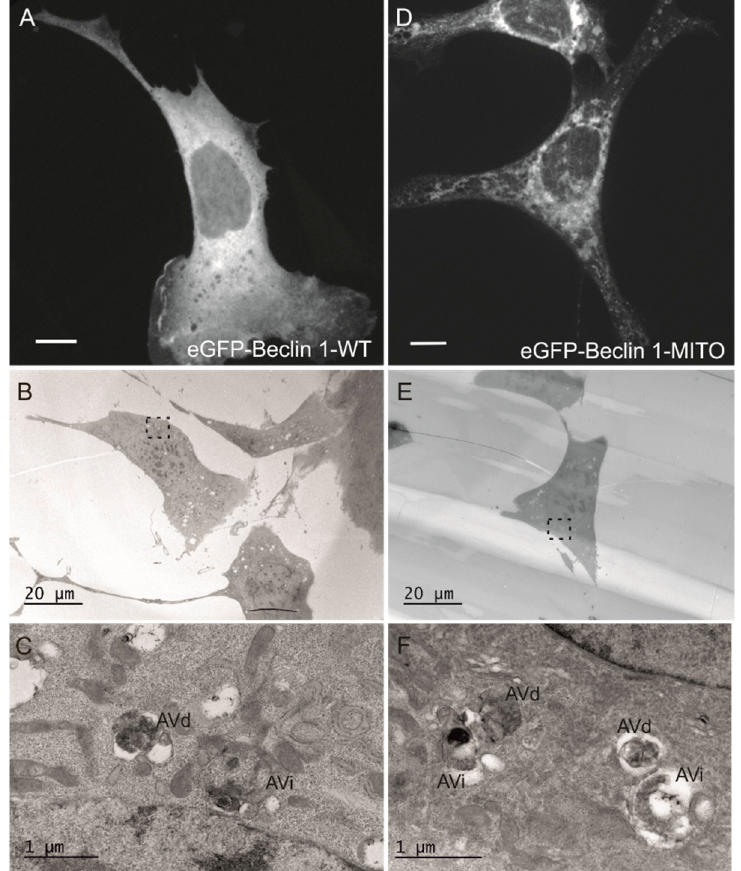
Figure 7. Electron microscopy analysis of autophagosomes in MEF-ULK1/2-KO cells expressing eGFP-Beclin 1-WT or eGFP-Beclin 1-MITO. The cells were transfected with eGFP-Beclin 1 constructs and starved in amino-acid free medium for 1 h before fixation. ( A – C ) eGFP-Beclin 1-WT. ( A ) Confocal image of a cell expressing eGFP-Beclin 1-WT. Scale bar, 10 μ m. ( B ) Electron micrograph of the same cell as in panel A. ( C ) Higher magnification of the boxed area in B, showing AVi (initial autophagic vacuoles/autophagosomes) and AVd (degradative autophagic vacuoles). ( D – F ) eGFP-Beclin 1-MITO. ( D ) Confocal image of a cell expressing eGFP-Beclin 1-MITO. Scale bar, 10 μ m. ( E ) Electron micrograph of the same cell as in panel D. ( F ) Higher magnification of the boxed area in E, showing AVi and AVd.